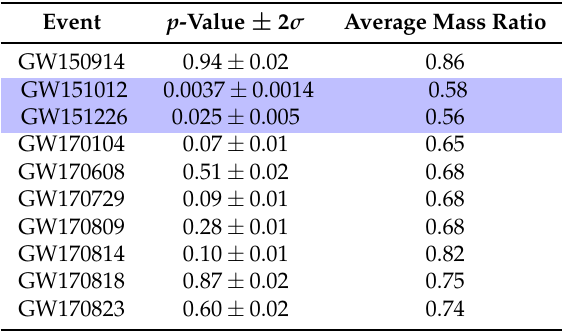
Table 14. Events, p -values reported in [25], and average mass ratio of event. Highlighted rows are the most significant post-coalescence signals reported in [25].